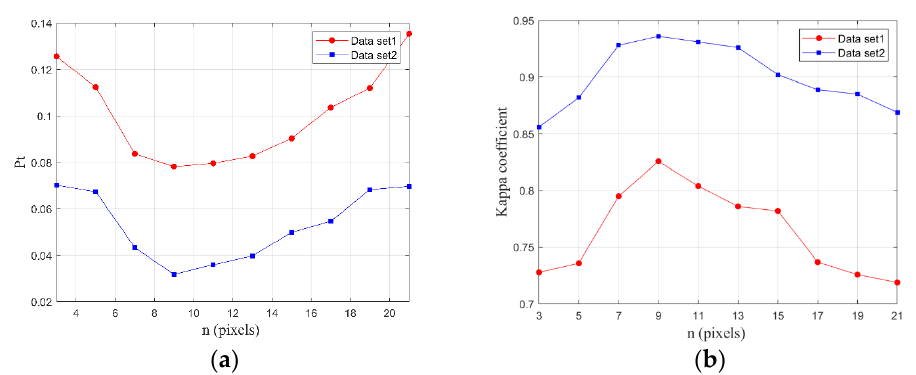
Figure 8. The relationship between n and accuracy. ( a ) Pt- n curves; ( b ) Kappa coefficient- n curves. Figures 9 and 10 depict change the magnitude images and the corresponding binary change